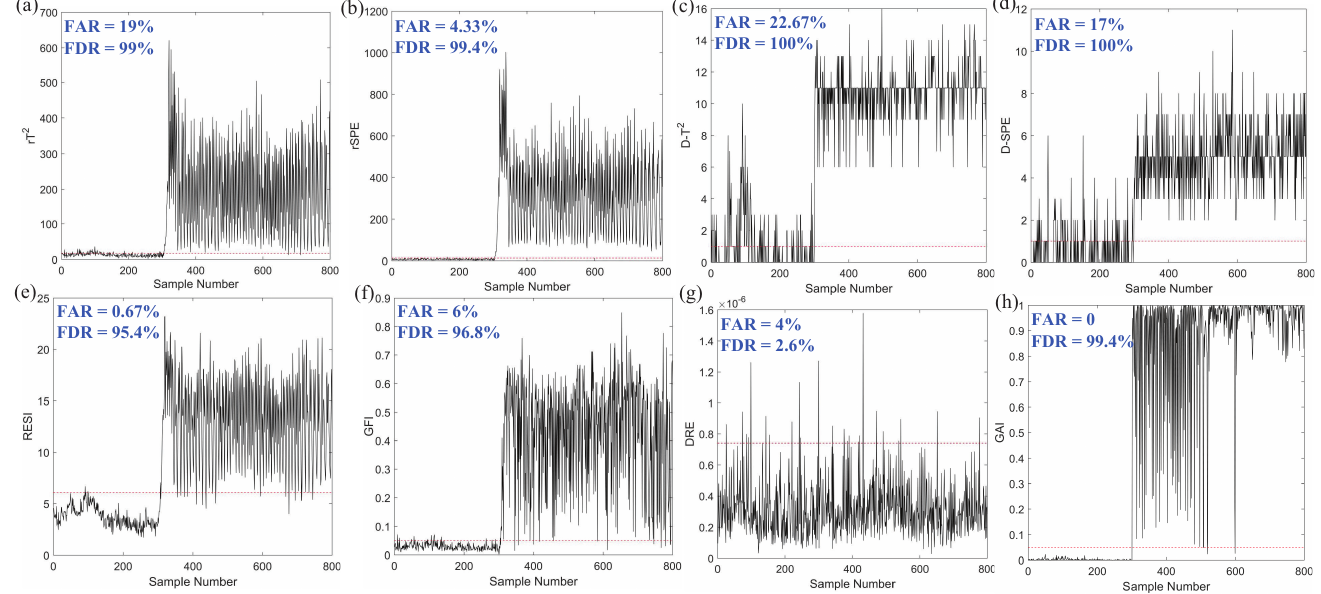
Figure 9. The process monitoring results of TE process with IDV (14). ( a ) rPCA- rT 2 ; ( b ) rPCA- rSPE ; ( c ) DPCA- D − T 2 ; ( d ) DPCA- D − SPE ; ( e ) KSVD- RESI ; ( f ) DDL- GFI ; ( g ) DPL- DRE ; ( h ) DRDPL- GAI .